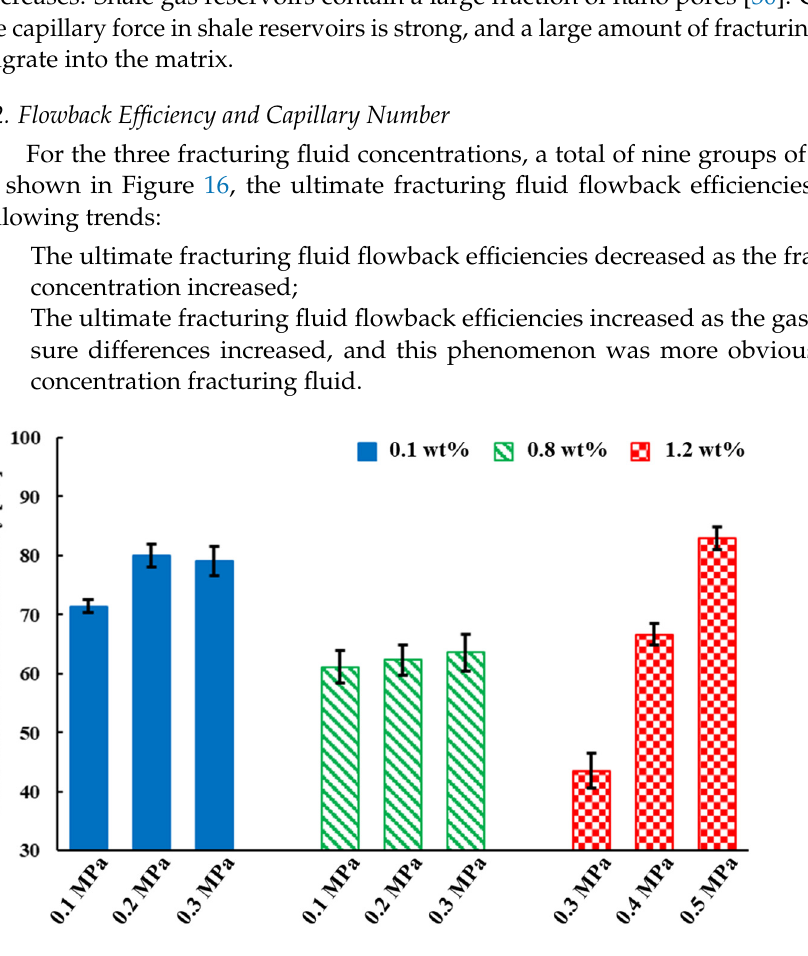
Figure 16. The ultimate fl owback e ffi ciencies for nine experimental